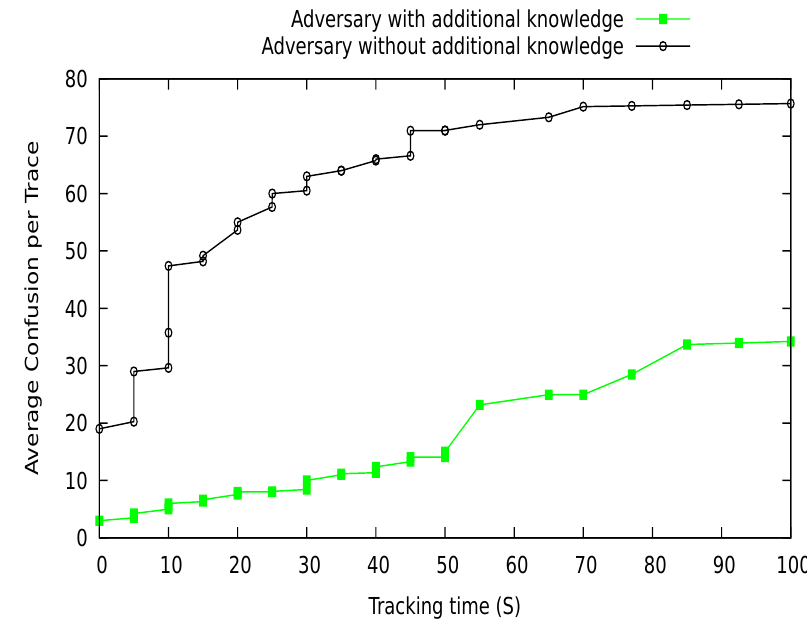
Figure 24. Rate of adversary confusion at various tracking